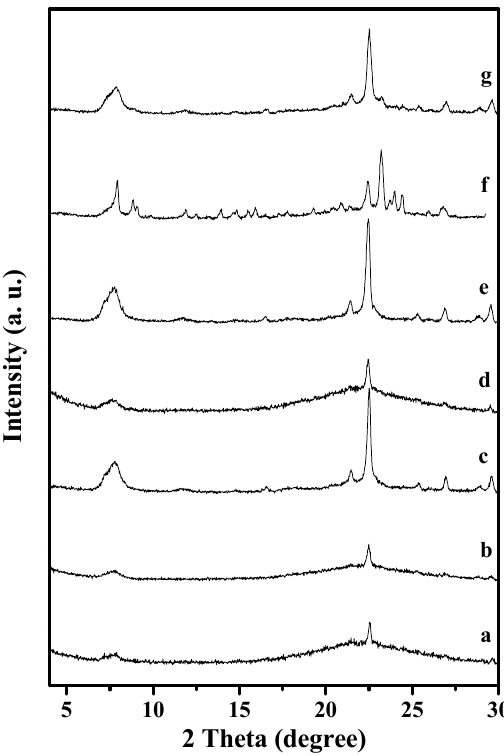
Figure 6. XRD patterns of solid samples synthesized from the starting gels with molar ratio of 1.0 SiO 2 /0.5–1.25 NH 4 F/0.15–0.3 TEABr with mass ratios of 0–10% seeds to the silica source at 120–160 °C for 60 h. ( a ) 0% Seeds to the silica source; NH 4 F/SiO 2 ratios of ( b ) 0.5; and ( c ) 1.0; TEABr/SiO 2 ratios of ( d ) 0.15; and ( e ) 0.25; ( f ) 160 °C for 60 h; ( g ) 120 °C for 60 h.